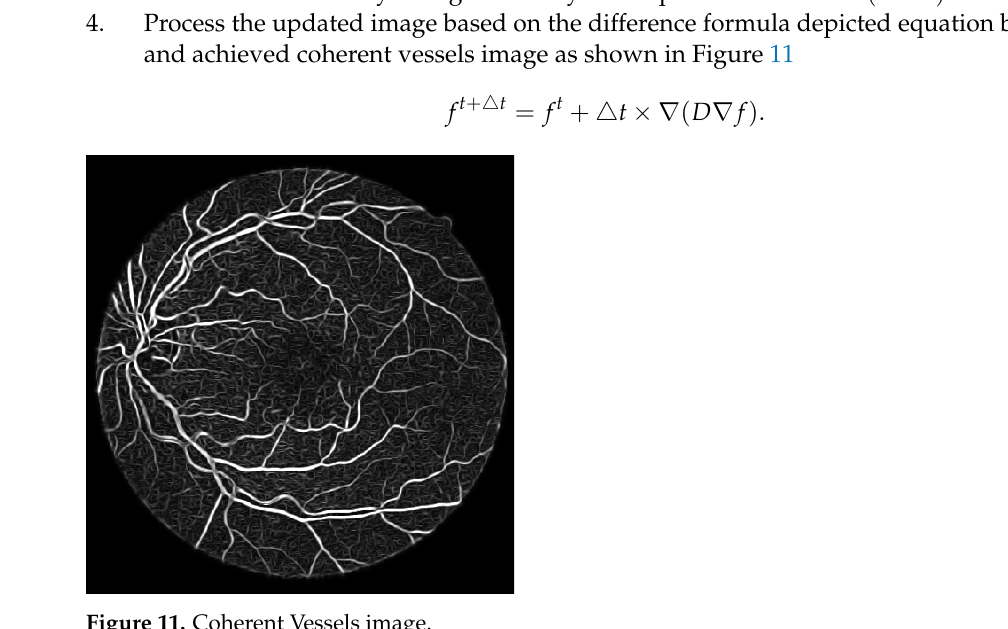
Figure 11. Coherent Vessels